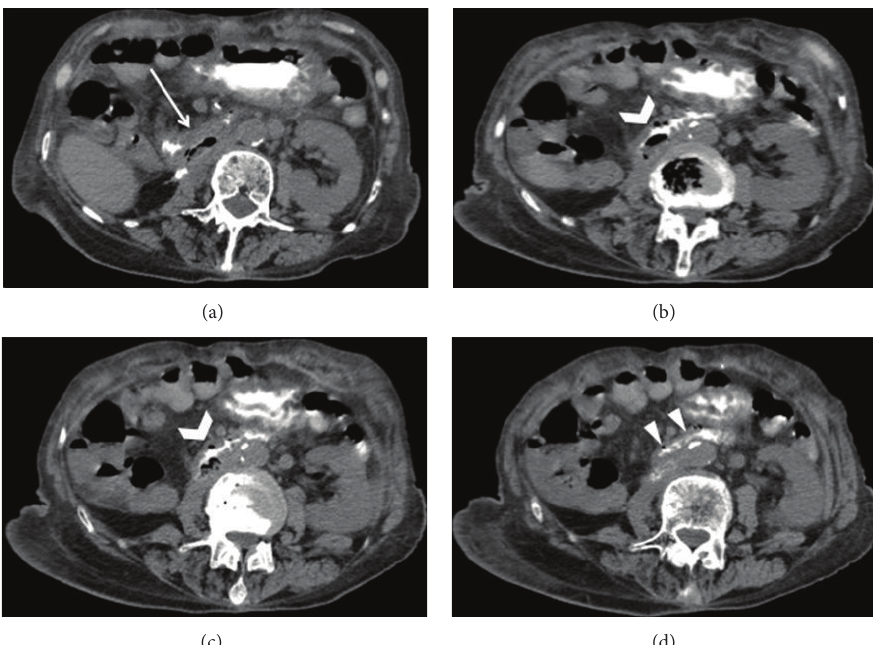
Figure 2: Transverse abdominal unenhanced CT scan acquired after oral administration of a water-soluble contrast agent. The images show the collapse of the second part of the duodenum (white arrow (a)) and the presence of an air bubble collection (open arrow (b) and (c)) (35 × 35 × 15mm), located between the posterior wall of the duodenum and the collapsed IVC graft. The transaxial CT images of the lower tract of the duodenum demonstrate the trouble of assessing attenuation differences between IVC graft and luminal contrast agent (arrowheads